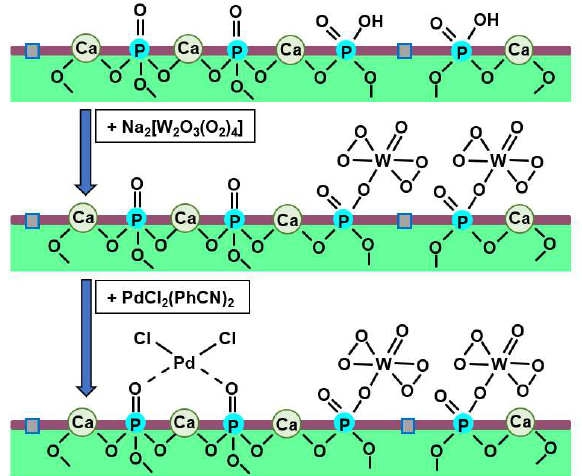
Figure 9. The route in the synthesis of the hybrid compound Pd-PW-HAP.